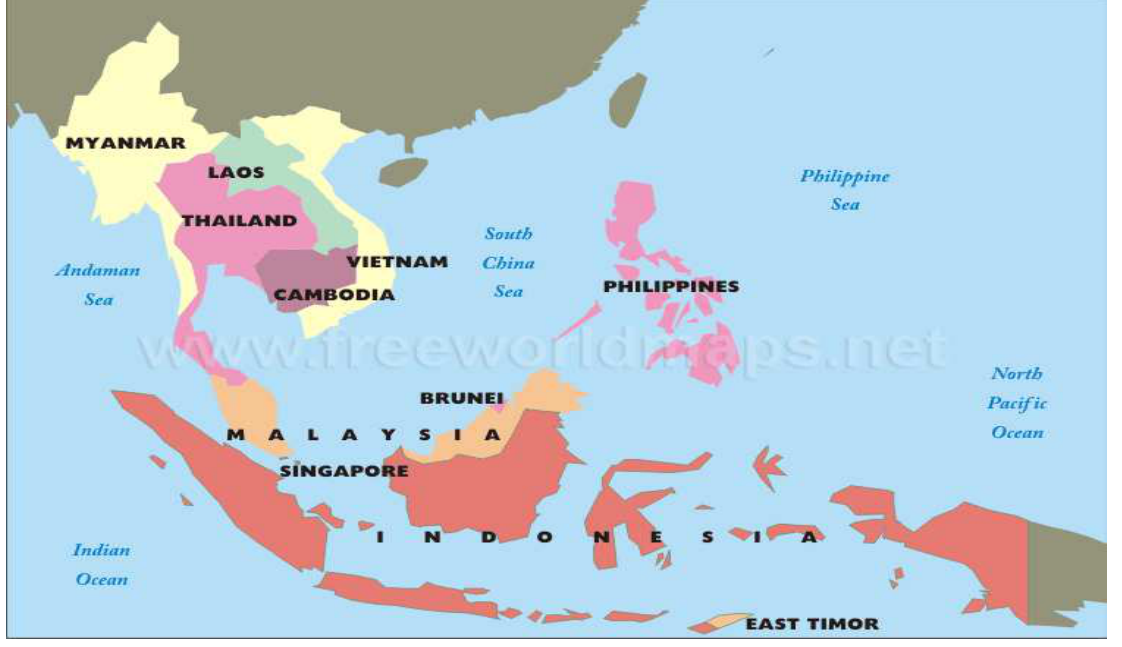
Fig. 1. The map of SEA region Source: Free World Maps (2005). Table 1. General economic indicators of each country in